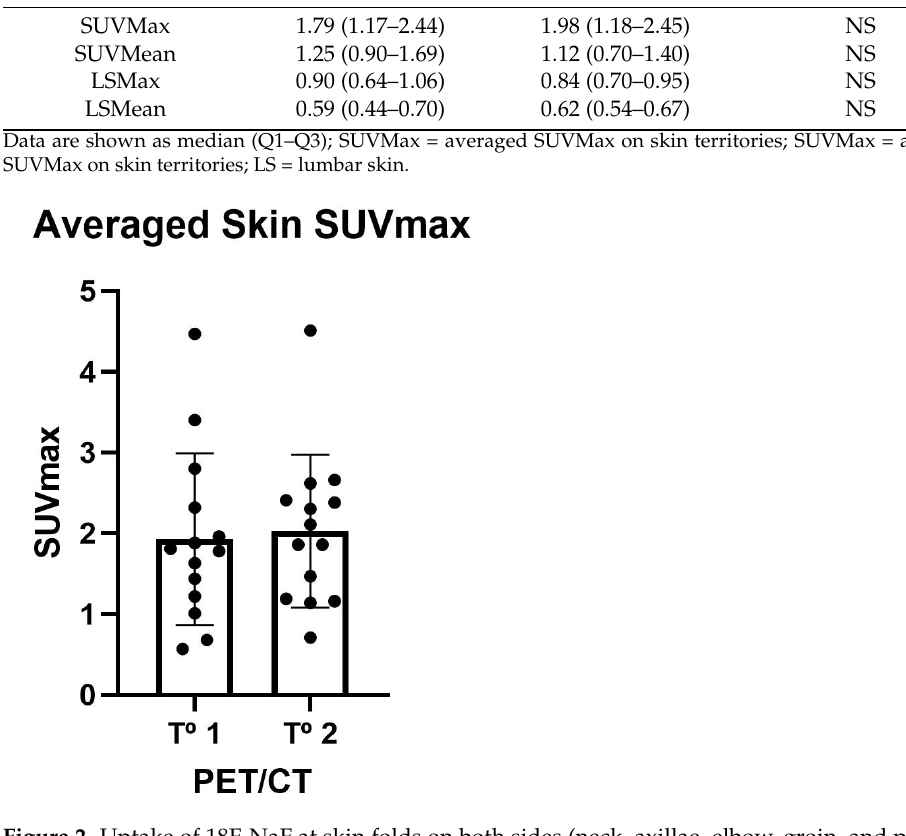
Figure 2. Uptake of 18F-NaF at skin folds on both sides (neck, axillae, elbow, groin, and popliteal area). Figure shows individual and averaged SUVmax of the skin.